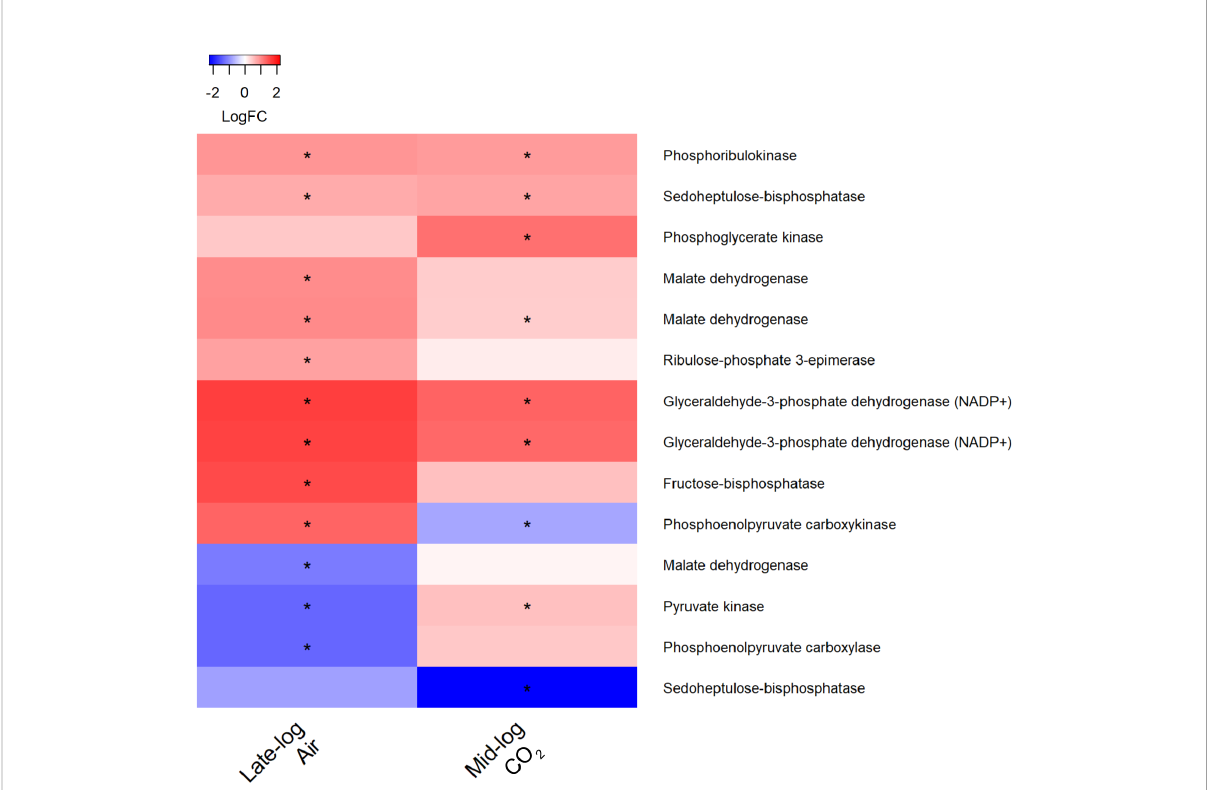
FIGURE 11 Heat map of differentially expressed transcripts encoding enzymes in the carbon fi xation pathway in S. obliquus grown in the presence of switchgrass during late-log and mid-log phase growth in ambient (i.e., air) and 1% CO 2 , respectively. Differential expression is presented from a mean of triplicate samples as the log fold change of transcripts from cultures containing switchgrass compared to cultures of the algae alone. Stars indicate an adjusted p-value of less than